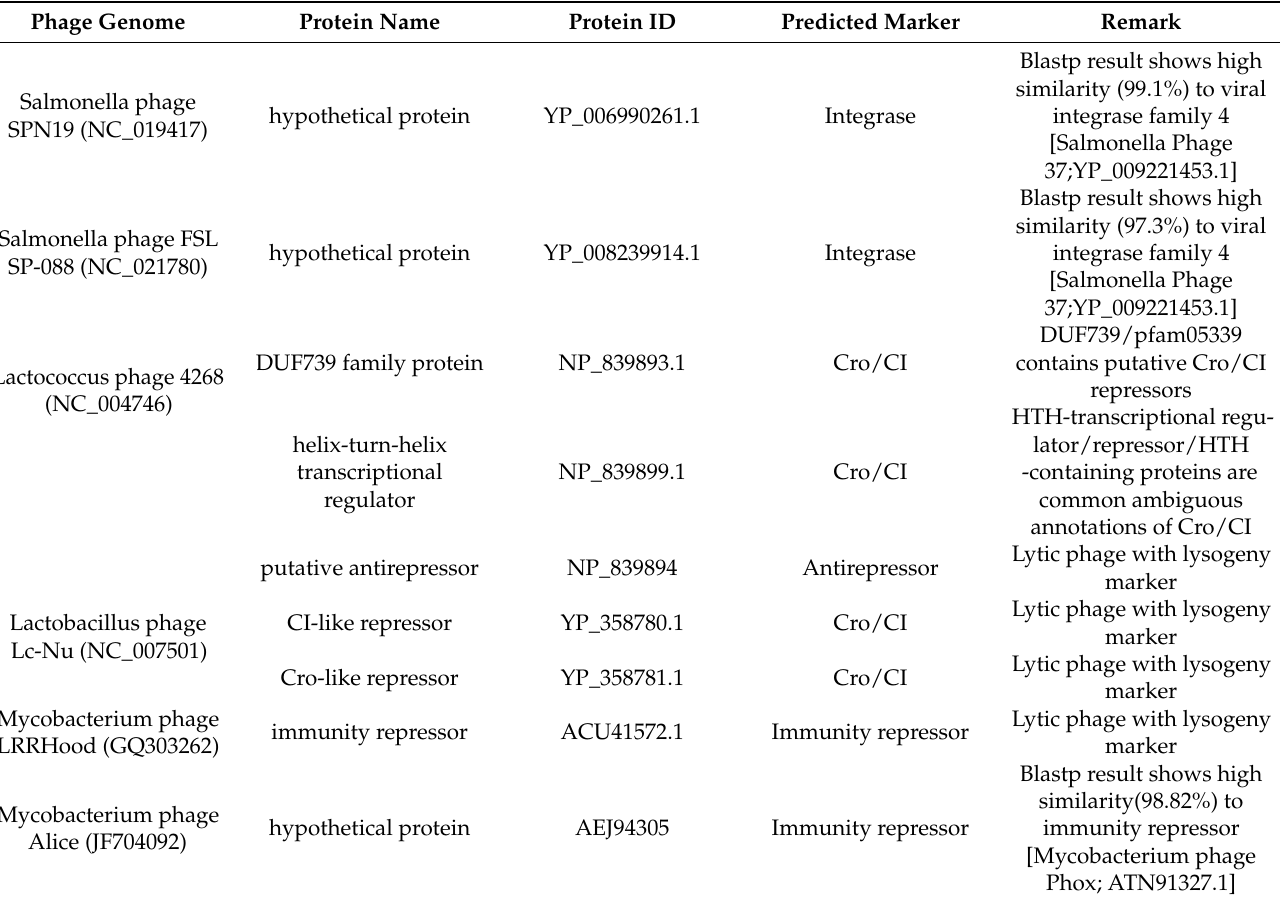
Table 4. Lytic phages that have been predicted as temperate phages (false positive) that contained actual and putative temperate